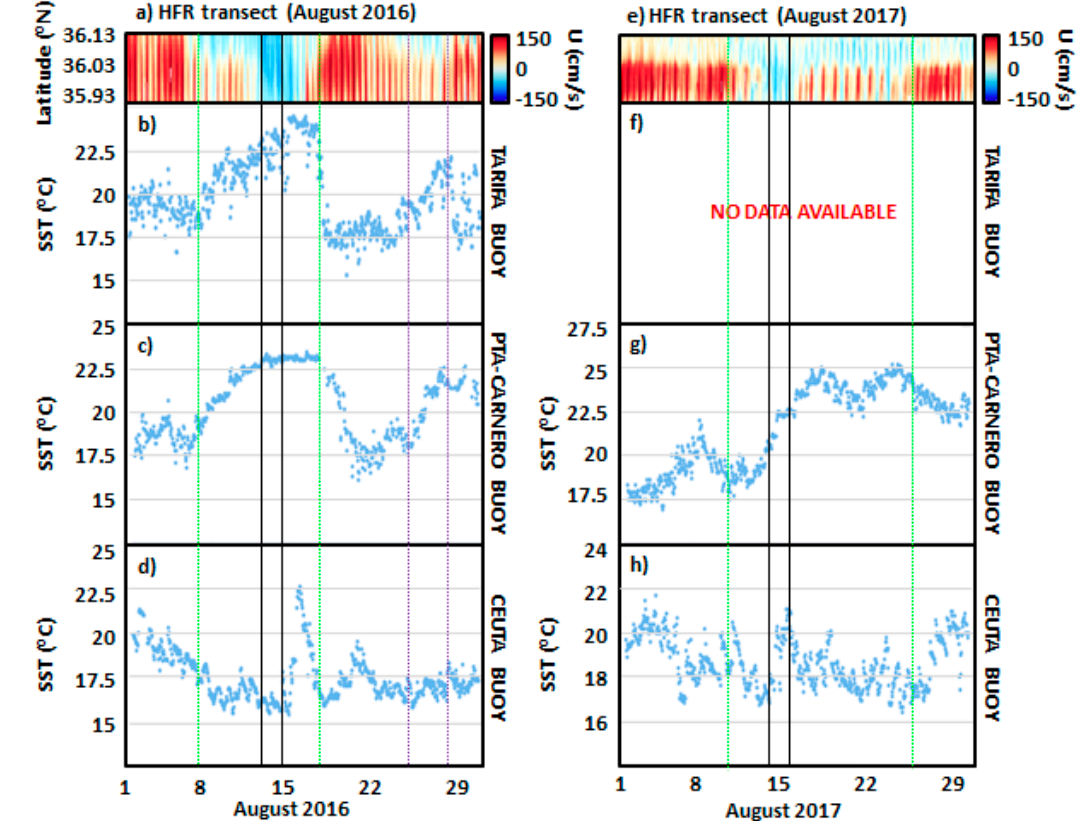
Figure 12. ( a – d ) Monthly Hovmöller diagram of High-Frequency Radar (HFR)-derived zonal current speed at the selected transect in the Strait of Gibraltar for August 2016 along with monthly timeseries of in situ sea surface temperature (SST) recorded by three coastal buoys deployed in the study area: Tarifa, Punta Carnero and Ceuta. ( e – h ) Idem, for August 2017. Two full Atlantic Jet (AJ) reversal episodes marked with black boxes for the 13th–14th August 2016 (left) and 14th–15th August 2017 (right). Green and purple dotted lines denote the beginning and end of SST increase as a result of the partial inversion of the flow in the northern coastal area of the Strait, and the subsequent intrusion of warmer and saltier Mediterranean waters into the Strait.